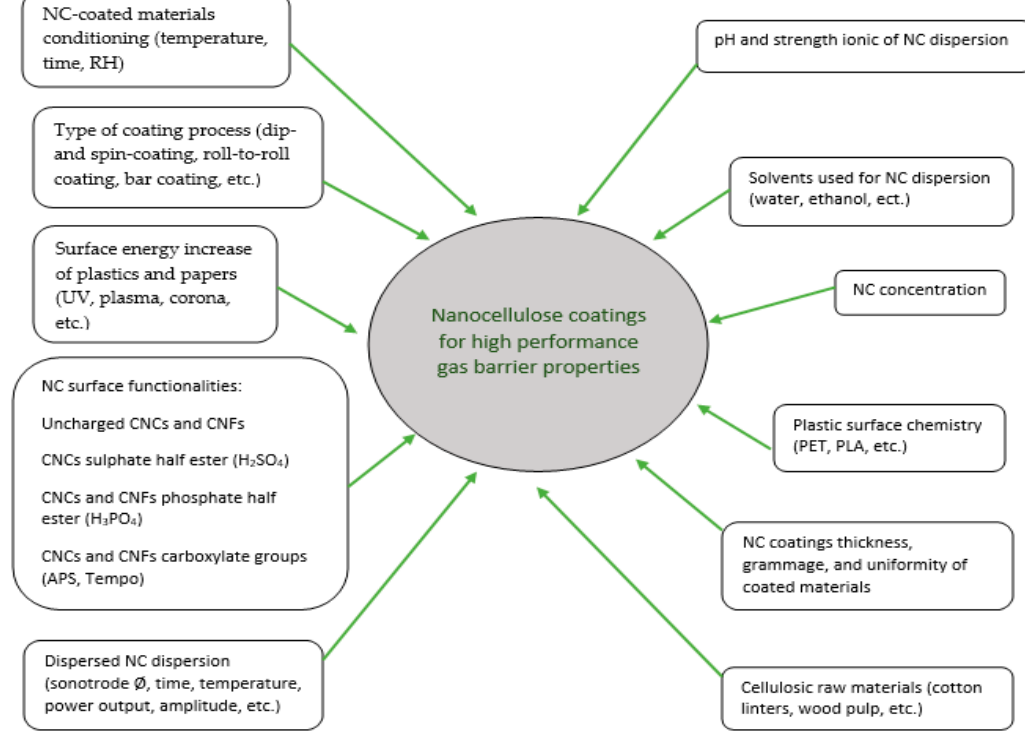
Figure 6. Critical factors for optimization of nanocellulose coating.